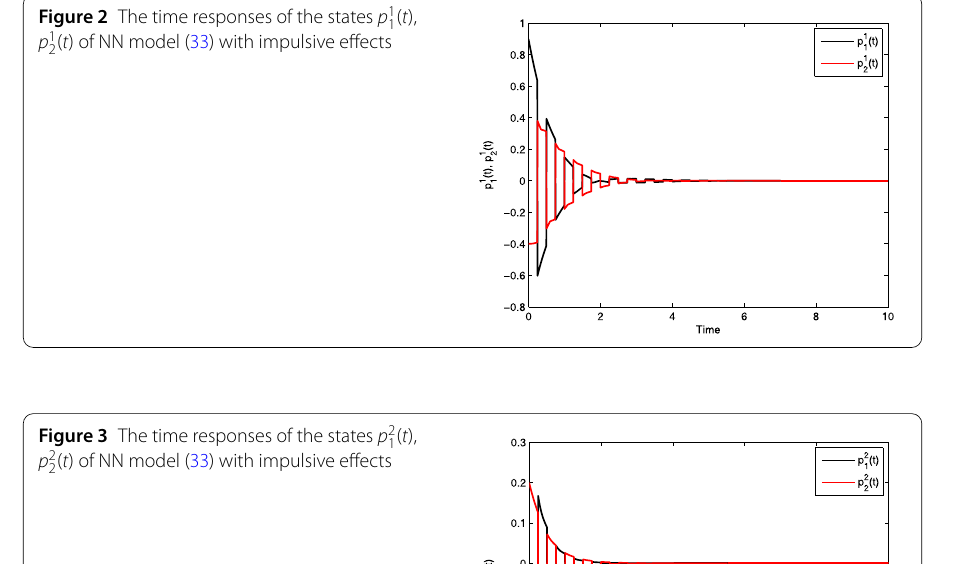
Figure 2 The time responses of the states p 1 1 ( t ), p 1 2 ( t ) of NN model (33) with impulsive effects